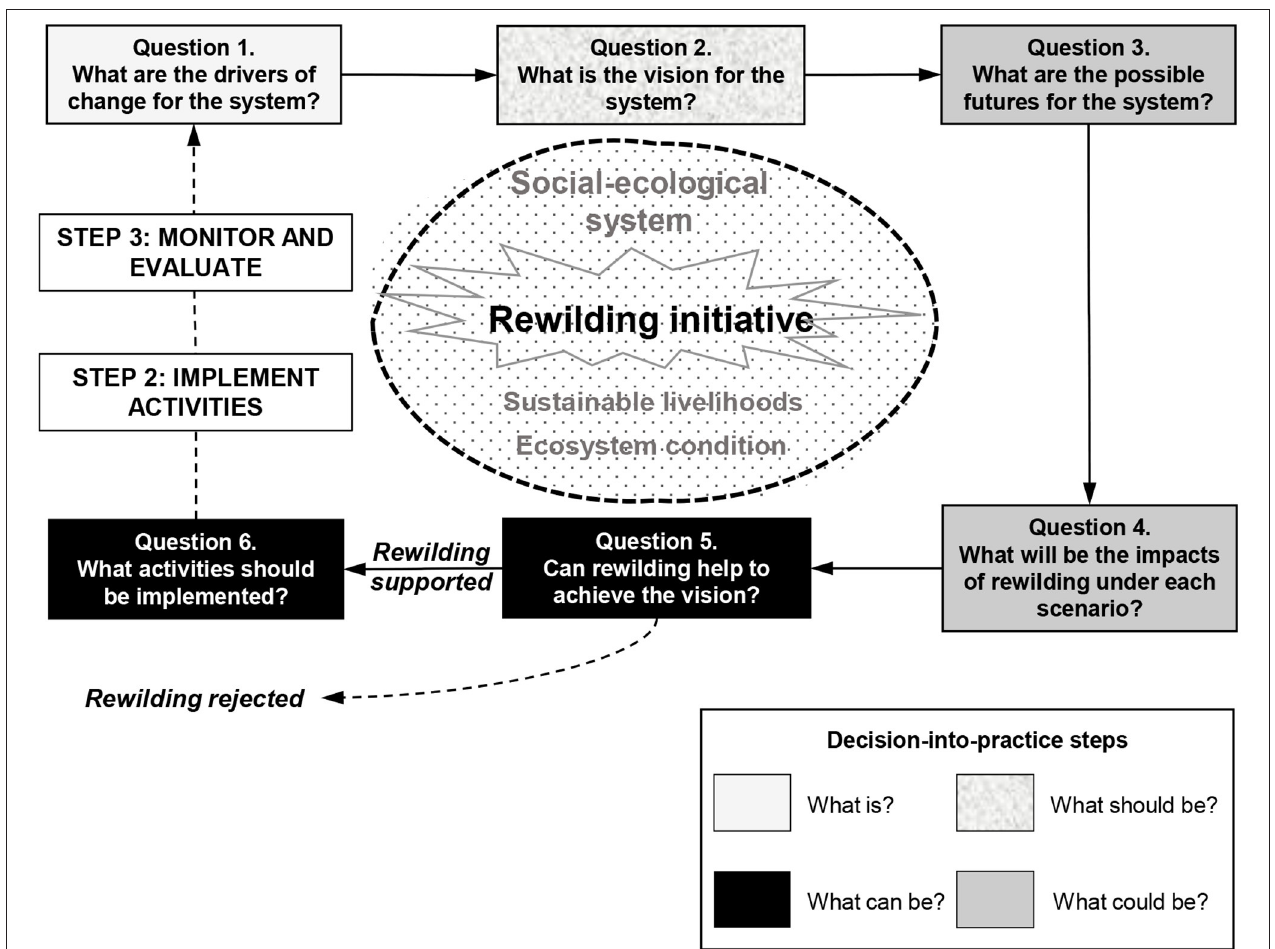
FIGURE 1 | The sequence of questions (1–6) involved in the decision-into-practise exercise proposed for Step 1 (plan and design). If the rewilding initiative is supported after Question 5 then the outcome of Question 6 leads to Step 2 (implement activities) and Step 3 (monitor and evaluate). The process then cycles back into Step 1 and the sequence of questions is repeated in subsequent adaptive management